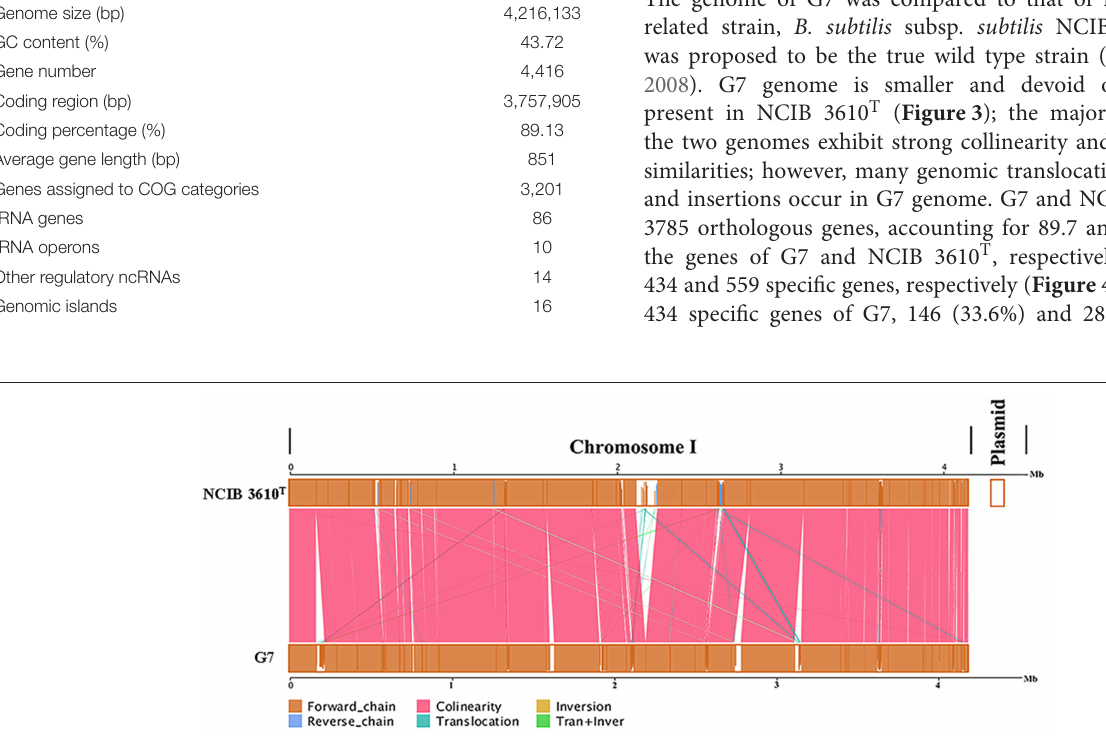
FIGURE 3 | Genome alignments for G7 and NCIB 3610 T using MUMmer. Upper and lower axes of linear synteny graph are constructed after the same proportion of size reduction in length of both sequences. According to BLAST results, each pair nucleic acid sequence of the two alignments is marked in the coordinate diagram according to its position information, and the height of the filled color in the block indicates similarity of sequence alignment. The color of the lines between the two axes indicates the type of comparison.